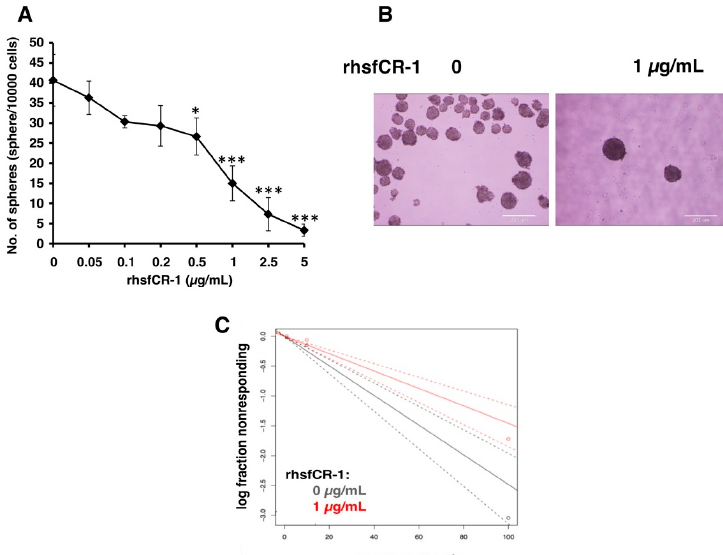
Figure 3. rhsfCR-1 attenuated the sphere formation ability of miPS-LLCcm cells. ( A ) The number of spheres were counted after the treatment with various concentrations of rhsfCR-1 for 1 week under non-adherent condition. Student t -test was conducted to analyze the significance (* p < 0.05, *** p < 0.001); ( B ) spheres in non-adherent cultures in serum free miPS medium supplemented with ITS-x. Spheres were photographed after the treatment with/without rhsfCR-1 (1 µg/mL) for 1 week using sphere formation assay; ( C ) extreme limiting dilution assay assessment of the limiting dilution sphere forming potential showed significantly reduced sphere formation of miPS-LLCcm cells in the presence of rhsfCR-1 at a high cell density per well in 96-well low attachment plates. (See Materials and Methods, Section 4).